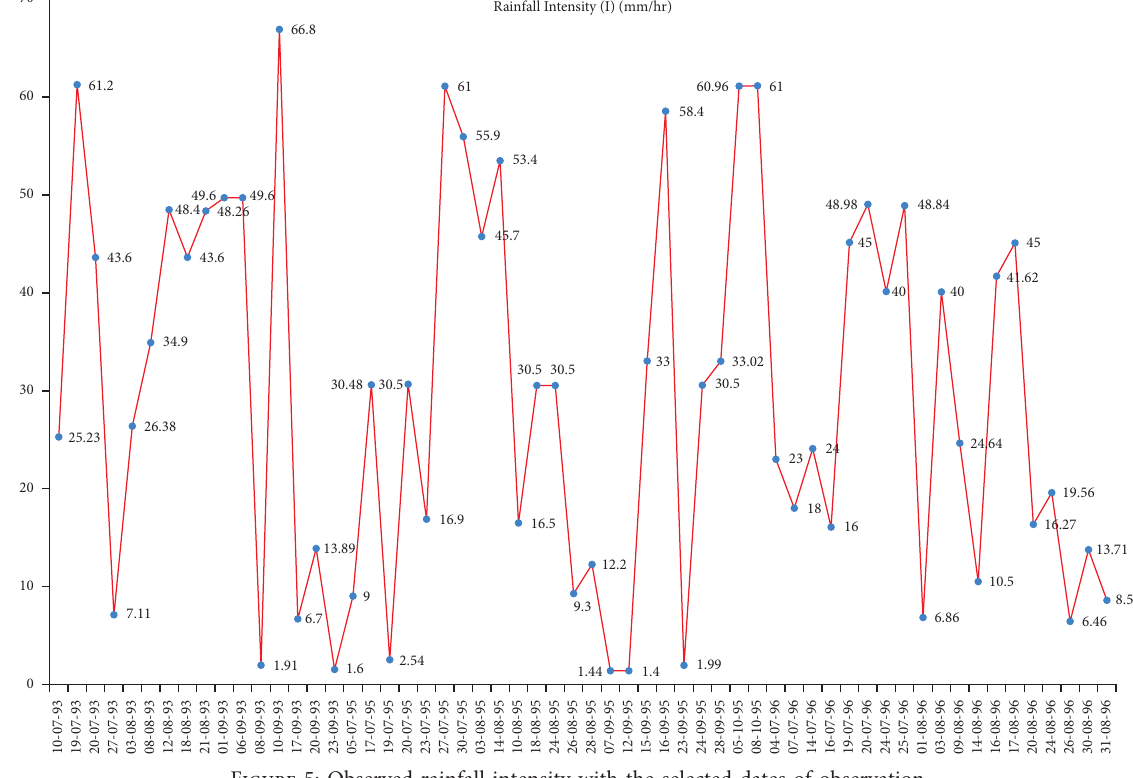
Figure 5: Observed rainfall intensity with the selected dates of observation.